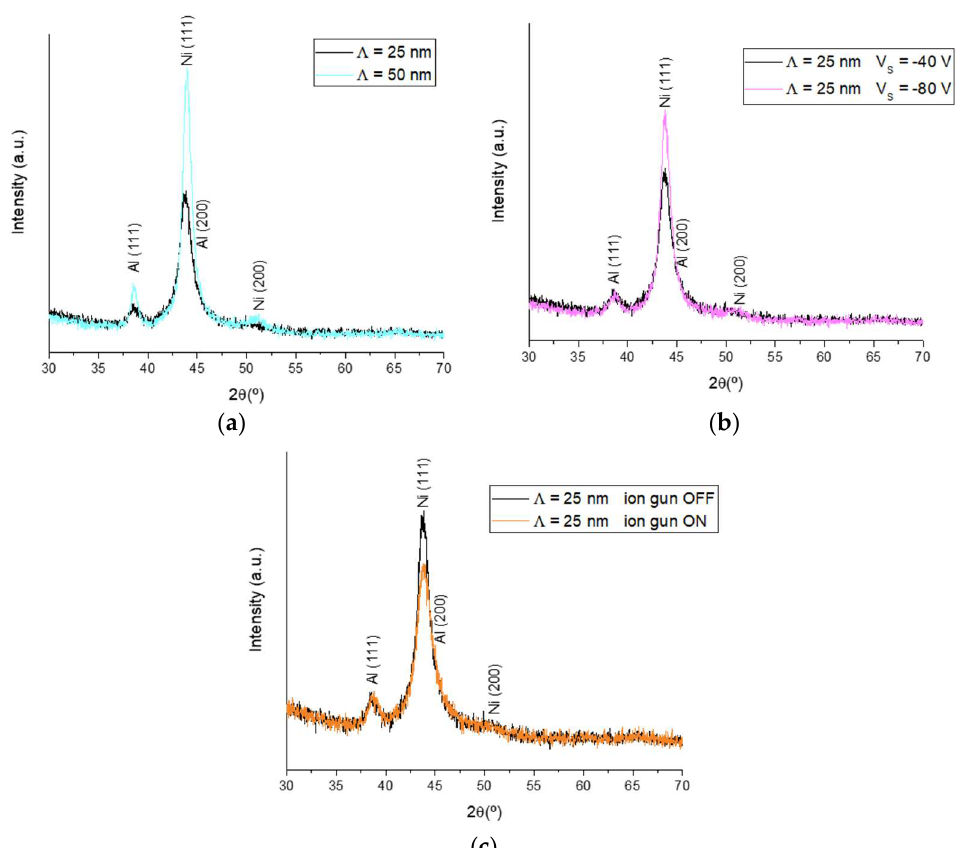
Figure 1. X-ray diffractograms of Al/Ni (V) multilayer films. ( a ) Modulation period ( Λ ); ( b ) Substrate bias ( V S ); ( c ) Ion gun.